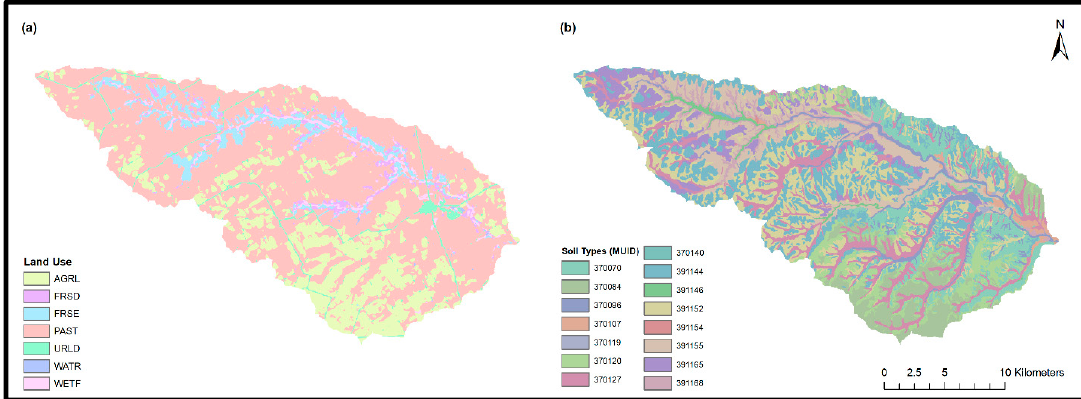
+ : ( a ) land use; and, ( b ) soil